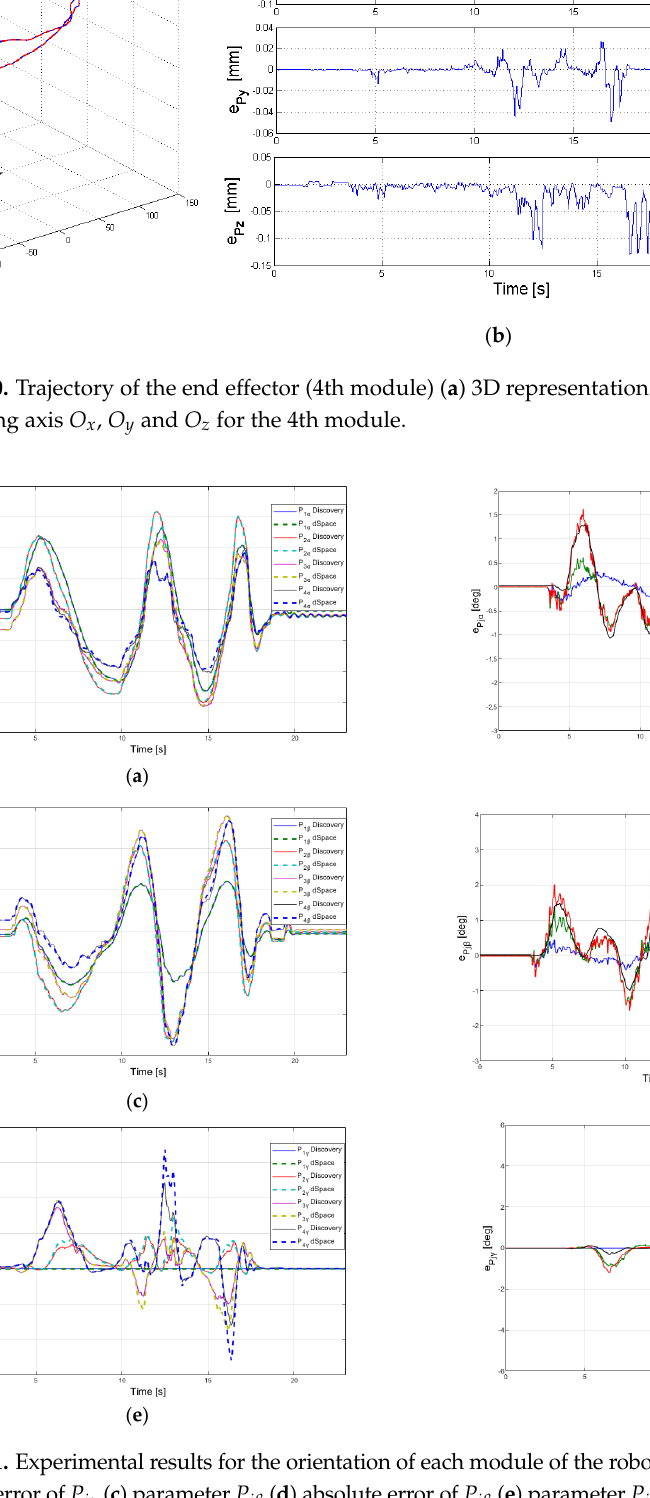
of P j γ . absolute error of P j α ( c ) parameter P j β ( d ) absolute error of P j β ( e ) parameter P j γ ( f ) absolute error of P j γ